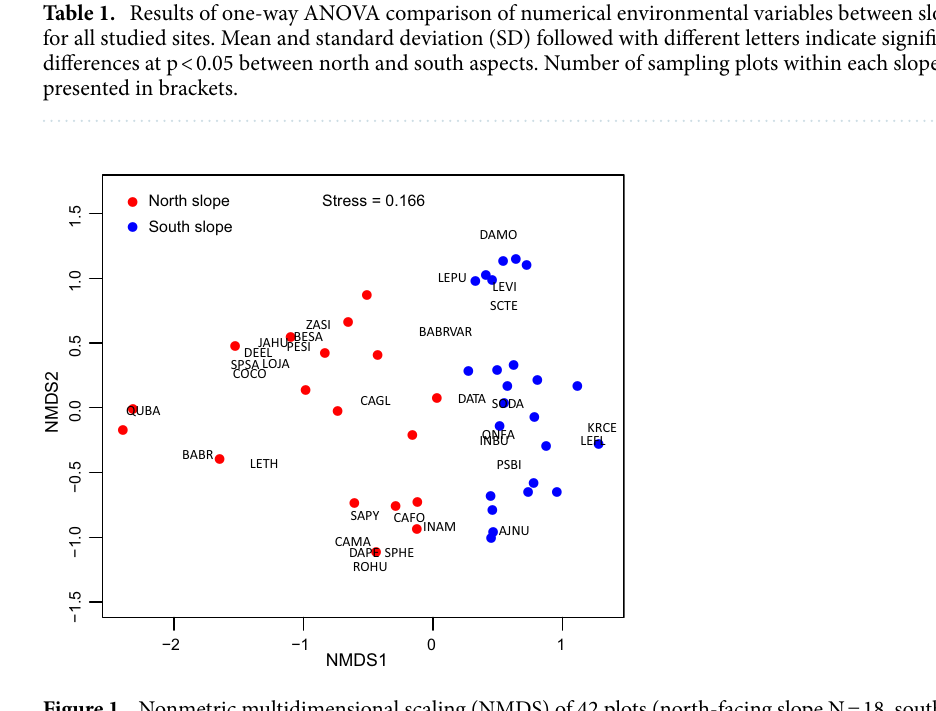
Figure 1. Nonmetric multidimensional scaling (NMDS) of 42 plots (north-facing slope N = 18, south-facing slope N = 24) based on Bray–Curtis dissimilarity (stress = 0.166). Plots located on different slope aspects were represented by different colors: red (north slope); blue (south slope). Species abbreviation: Quercus baronii (QUBA), Bauhinia brachycarpa (BABR), Desmodium elegans (DEEL), Jasminum humile (JAHU), Spiraea salicifolia (SPSA), Lonicera japonica (LOJA), Cotinus coggygria (COCO), Pertya sinensis (PESI), Berberis sargentiana (BESA), Zanthoxylum simulans (ZASI), Sageretia pycnophylla (SAPY), Caryopteris forrestii (CAFO), Campylotropis_macrocarpa (CAMA), Daphne penicillate (DAPE), Rosa hugonis (ROHU), Spiraea henryi (SPHE), Indigofera amblyantha (INAM), Caryopteris terniflora (CATE), Sophora davidii (SODA), Bauhinia brachycarpa var. microphylla (BABRVAR), Onosma farreri (ONFA), Indigofera bungeana (INBU), Caryopteris bicolor (CABI), Leptodermis purdomii (LEPU), Daphne tangutica (DATA), Lespedeza virgate (LEVI), Ajania nubigena (AJNU), Lespedeza thunbergii (LETH), Lespedeza floribunda (LEFL), Caryopteris glutinosa (CAGL), Krascheninnikovia ceratoides (KRCE), and Daphne modesta